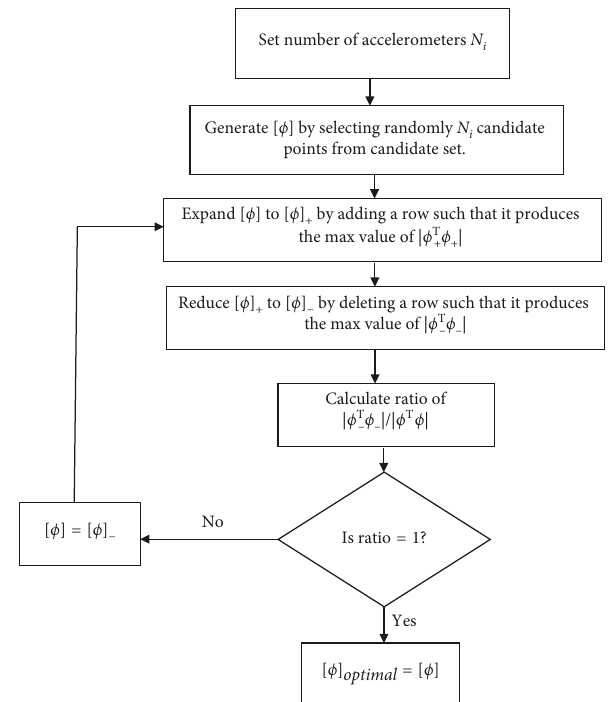
Figure 5: Flow chart of the D-optimum design